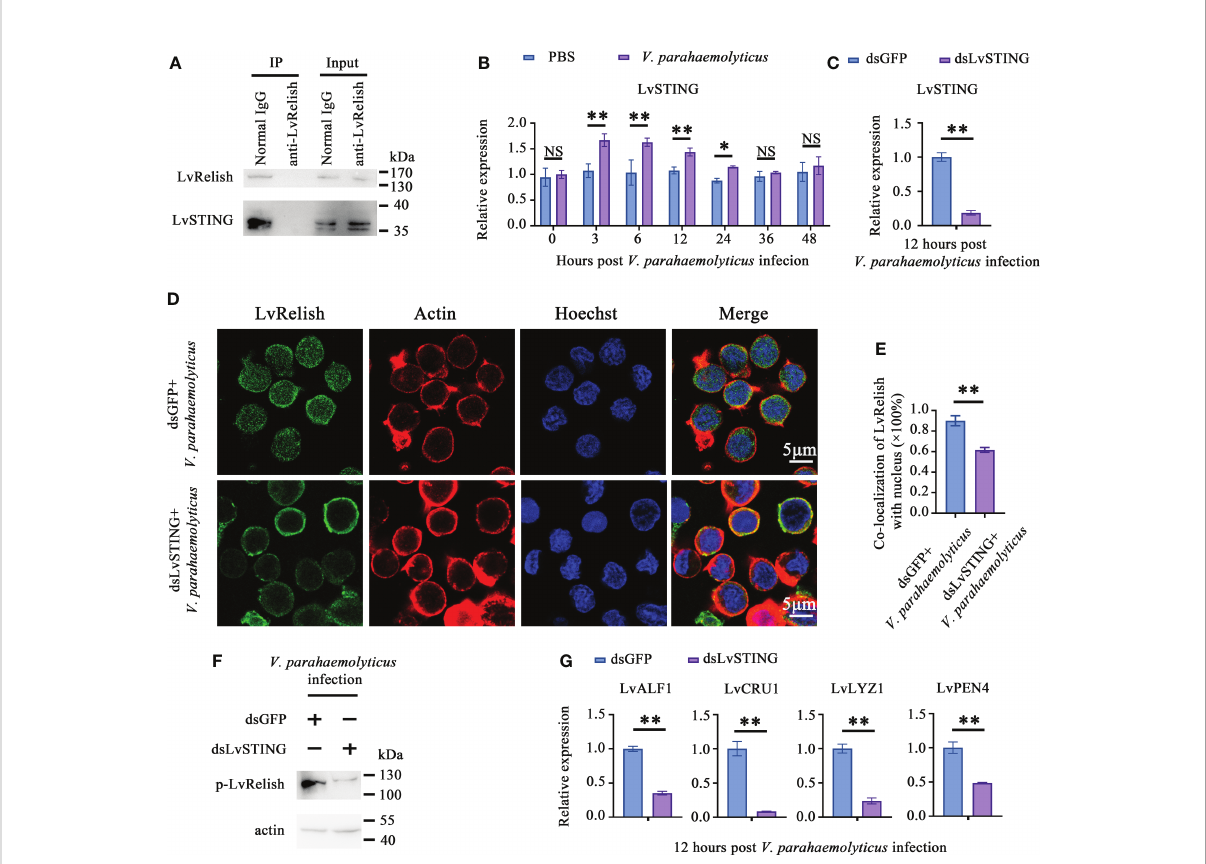
FIGURE 3 LvSTING prompted LvRelish activation in vivo . (A) IP assay detecting the interaction between LvSTING and LvRelish in vivo . (B) Expression pro fi les of LvSTING in hemocytes from PBS or V. parahaemolyticus challenged shrimp. The expression level at each time points were normalized to 0 h post PBS-injected group. (C) RNAi ef fi ciency of dsLvSTING in shrimp hemocytes. (D) LvRelish nuclear translocation in LvSTING silenced hemocytes infected by V. parahaemolyticus . (E) Co-localization of LvRelish and Hochest-stained nucleus in hemocytes corresponding to Figure 3D calculated by WCIF ImageJ software. (F) The phosphorylation levels of LvRelish in the hemocytes from dsLvSTING or dsGFP treated shrimp during V. parahaemolyticus infection. (G) The expression of AMPs in the hemocytes of dsLvSTING or dsGFP treated shrimp. The data was analyzed statistically by student ’ s T test (* p < 0.05, ** p <